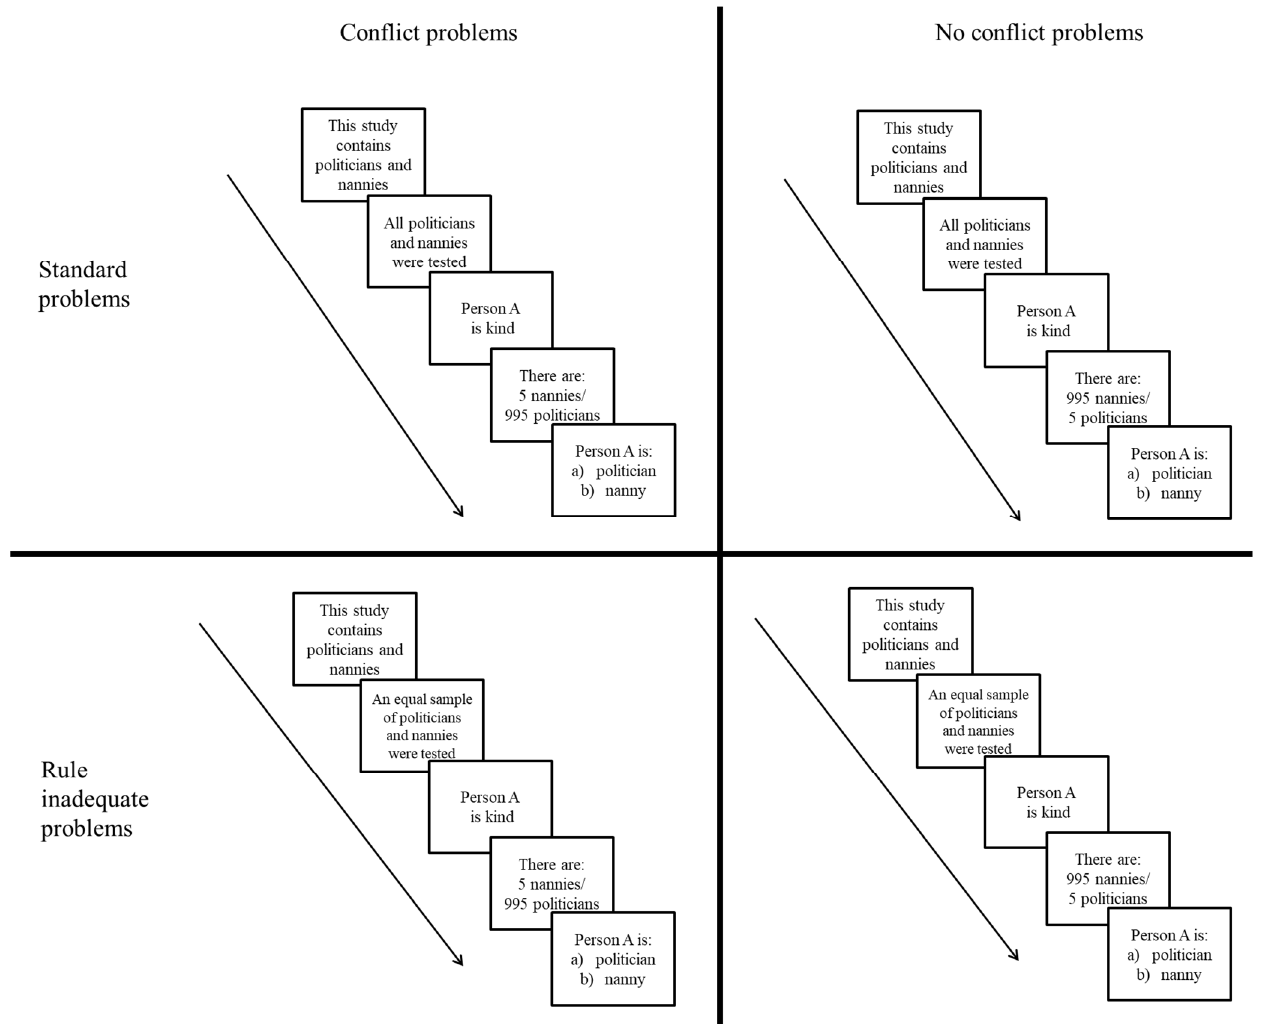
Figure A1. Examples for all variations of problems used in Experiment 2.